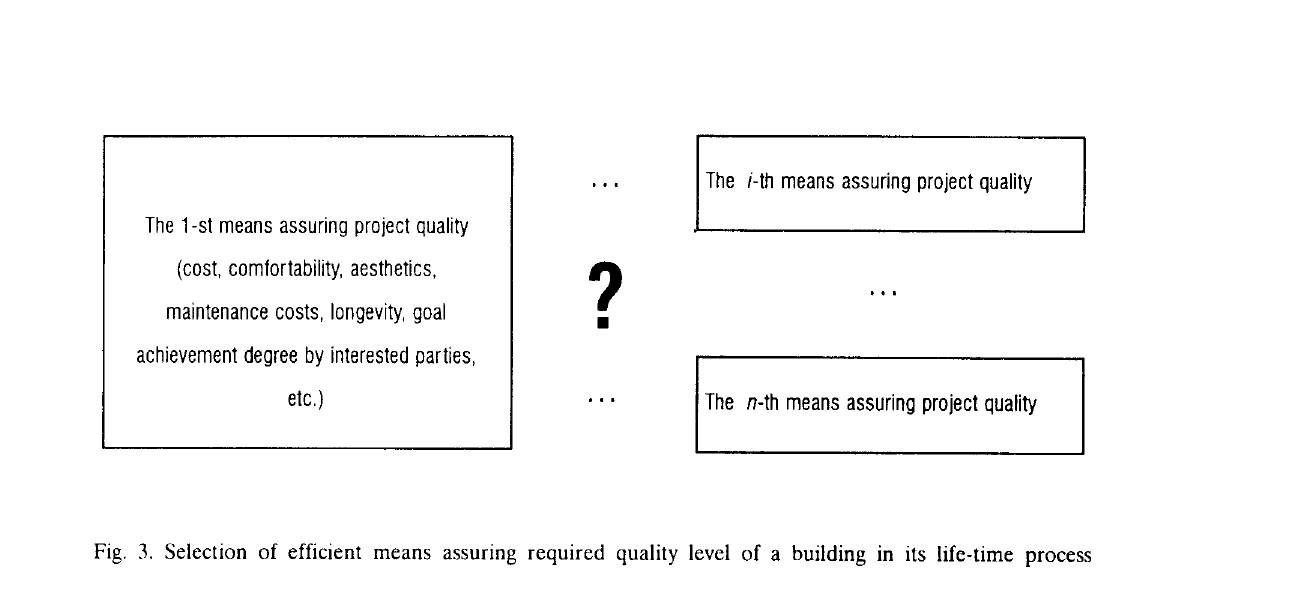
Typical interested parties, exerting influence on total quality